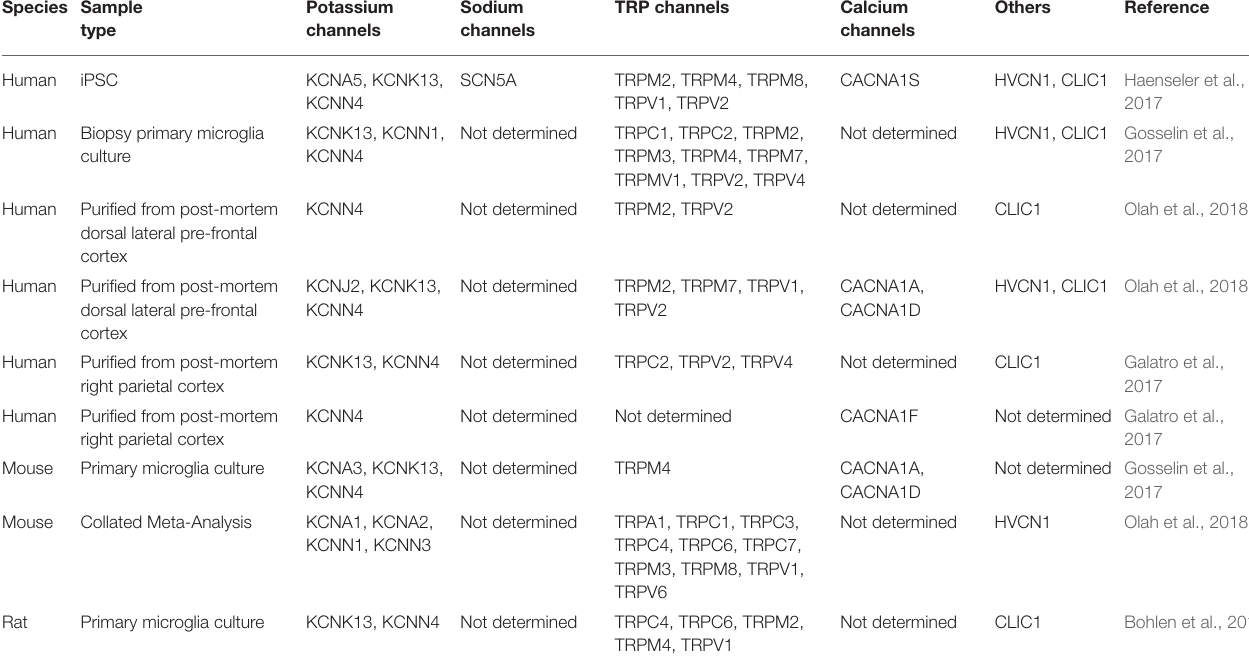
TABLE 2 | Comparison of multiple transcriptome studies of regulated microglial genes, relating to ion channels, in models of aging or Alzheimer’s disease. Species Sample